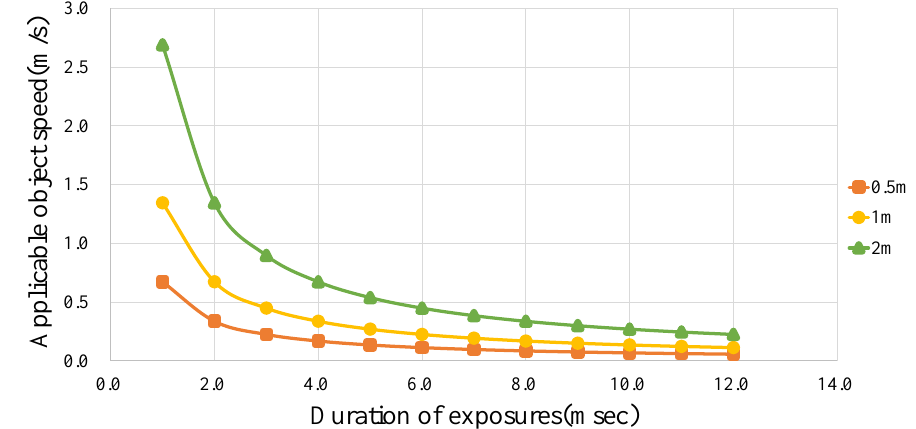
Figure 7. Relationship between applicable object speed and exposure duration for various distances between the camera and the target object (7). In this graph, we calculated the applicable object speed using a sensor pixel size of 16.8 µm and a camera lens focal length of 12.5 mm. As the figure shows, we need to set the exposure duration to be short while placing the target object far away from the image sensor to capture multiple images of a dynamic